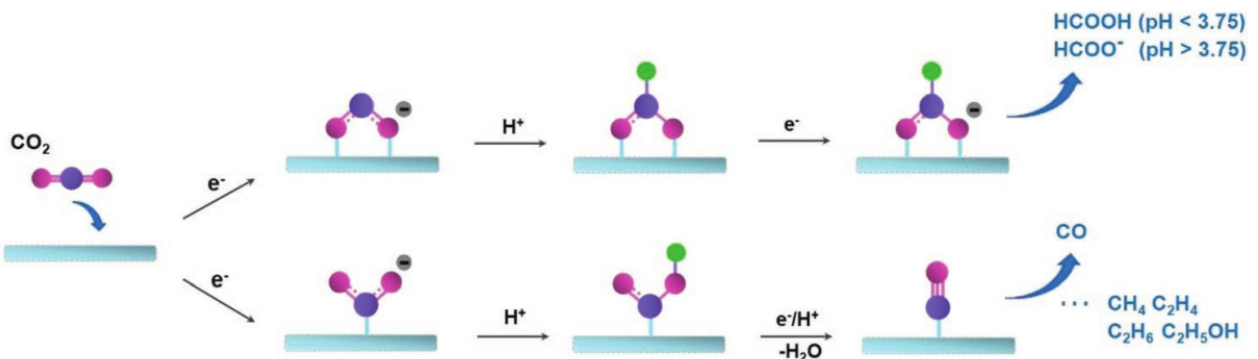
Figure 2. Different reaction pathways for electrocatalytic CO 2 reduction to produce valuable products. Reproduced with permission from Ref. [74]. Copyright 2020, Wiley-VCH Verlag Gmbh.